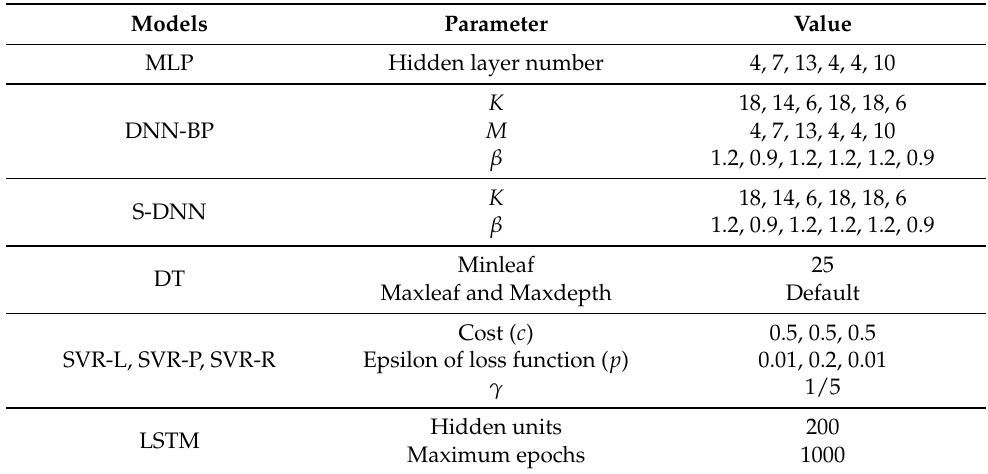
Table 7. Parameter values of the prediction models for the PM 2.5 concentration time series